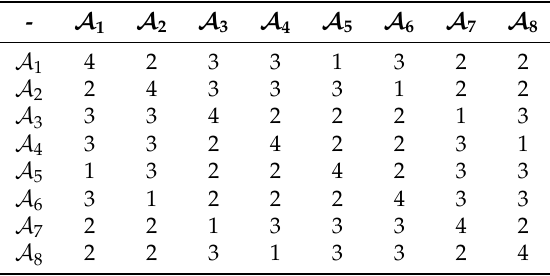
Table 1. The necessary number of crossings between two different subgraphs T i and T j for the configurations A k and A l